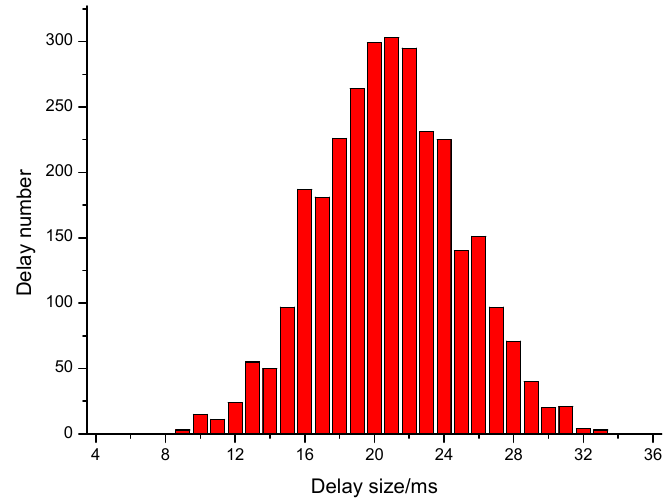
Figure 13. Time delay distribution after simulation of distribution.